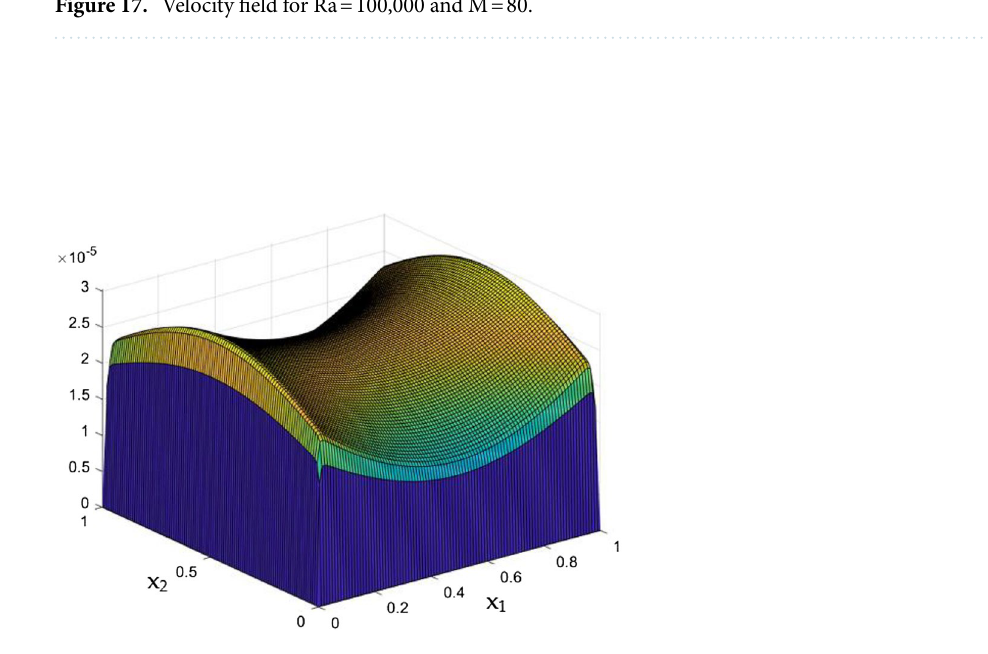
Figure 18. Velocity field for Ra = 100,000 and M =